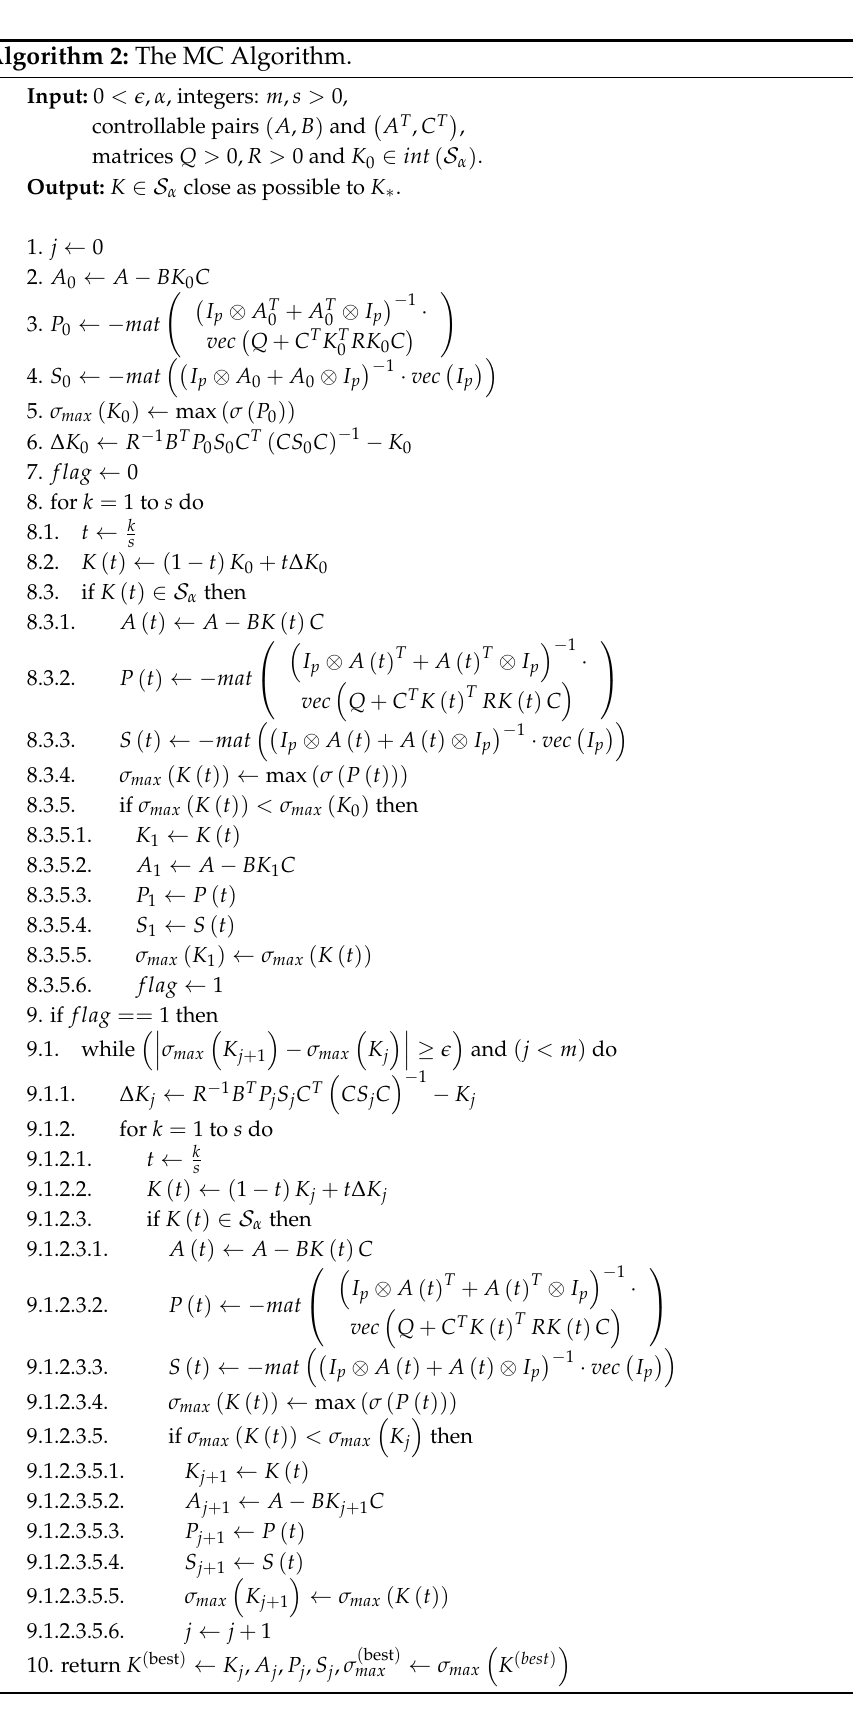
Algorithm 2: The MC